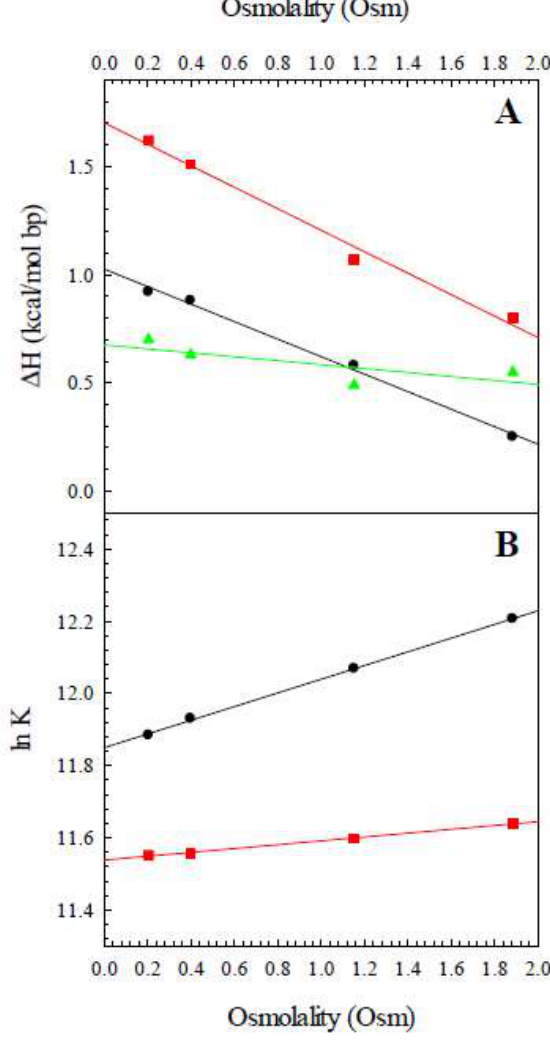
Figure 3. ( A ) Plots of ΔH obs , Z8A (black), ΔH obs , Z8B (red) and ΔH conf (green), calculated using Equation (2), versus osmolality for the titrations with Na + using betaine as the osmolyte. ( B ) Plots of lnK vs. osmolality for Z8A (black) and Z8M (red). Table 3. The change in enthalpies ( ∆ H) for of Z8A and Z8M resulting from their titrations with Na + in the absence or presence of